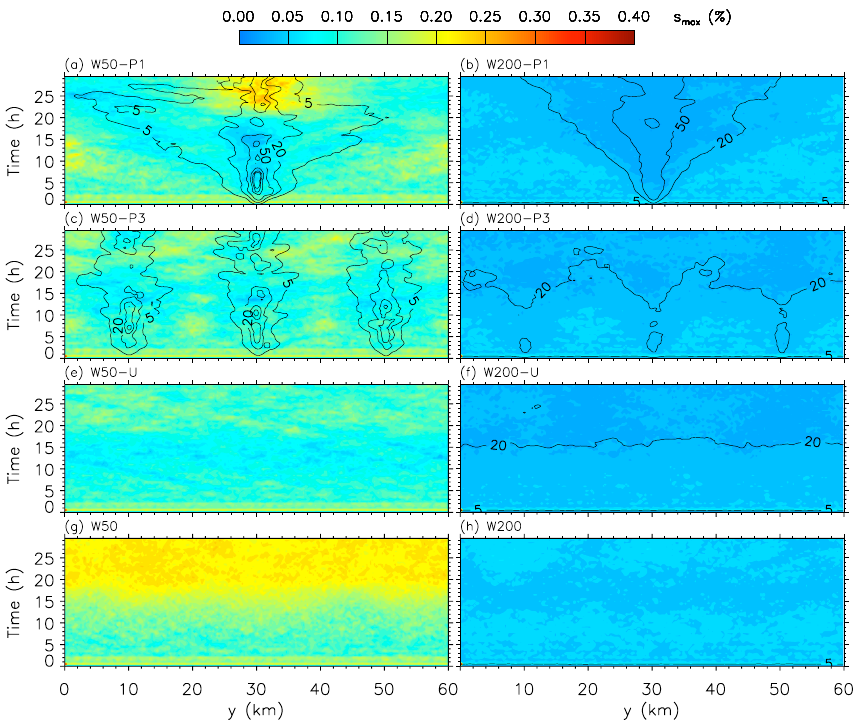
Fig. 3. Same as Fig. 2 but for in-cloud unactivated CCN number concentrations N c (black contours: 5, 20, 50, 100, 150, 200mg − 1 ) and maximum supersaturation